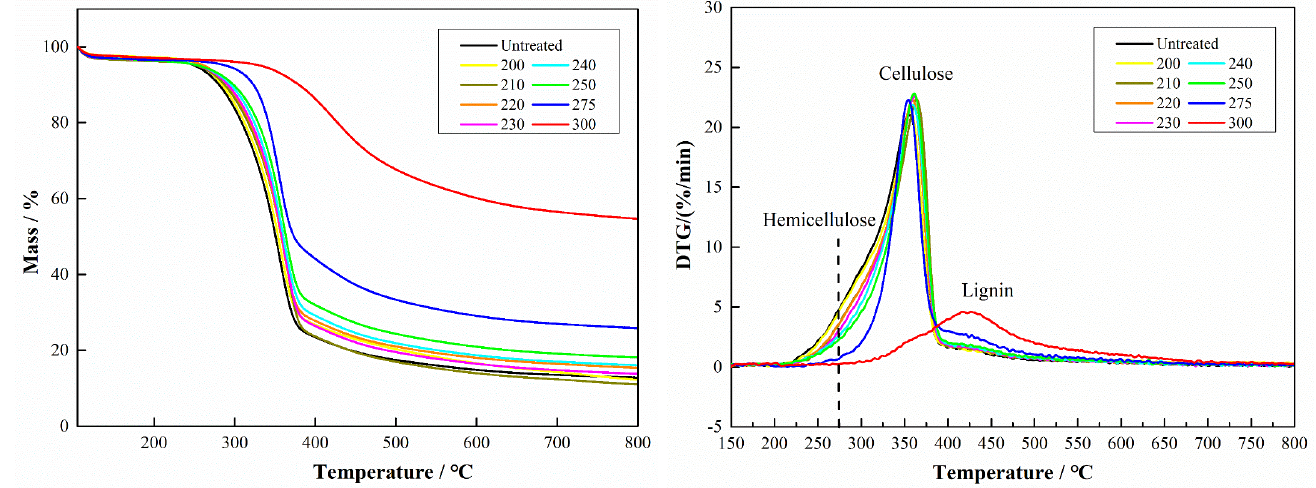
Figure 11. TG curves ( left ) and DTG ( right ) of fir in the heat treatment temperature 200–300 °C range.